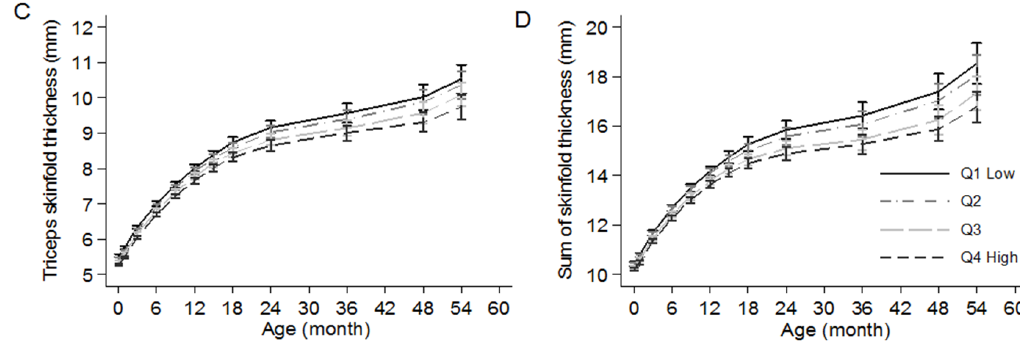
Figure 2. Predicted adjusted mean values with corresponding standard errors (from linear mixed effects models): ( A ) BMI z -score ( n = 1048); ( B ) subscapular skinfold thickness ( n = 1034); ( C ) triceps skinfold thickness ( n = 1036); and ( D ) sum of skinfolds thickness ( n = 1034) according to quartiles of maternal vegetables-fruit-and-white rice pattern score. The linear mixed effects models were adjusted for exact age at measurement, infant sex (except for BMI z -score), birth order, gestational age, duration of any breastfeeding, ethnicity, maternal age, height, pre-pregnancy BMI, weight gain until 26–28 weeks gestation, education level, gestational diabetes, energy intake, and scores of the other two dietary patterns (e.g., adjusting for SfN and PCB pattern scores for associations between VFR pattern and childhood adiposity). Median (range) of standardized dietary pattern scores: − 1.09 ( − 3.26, − 0.65) SD for Q1; − 0.31 ( − 0.64, − 0.02) SD for Q2; 0.28 ( − 0.02, 0.67) SD for Q3; 1.16 (0.68, 3.27) for Q4. Q, quartile.